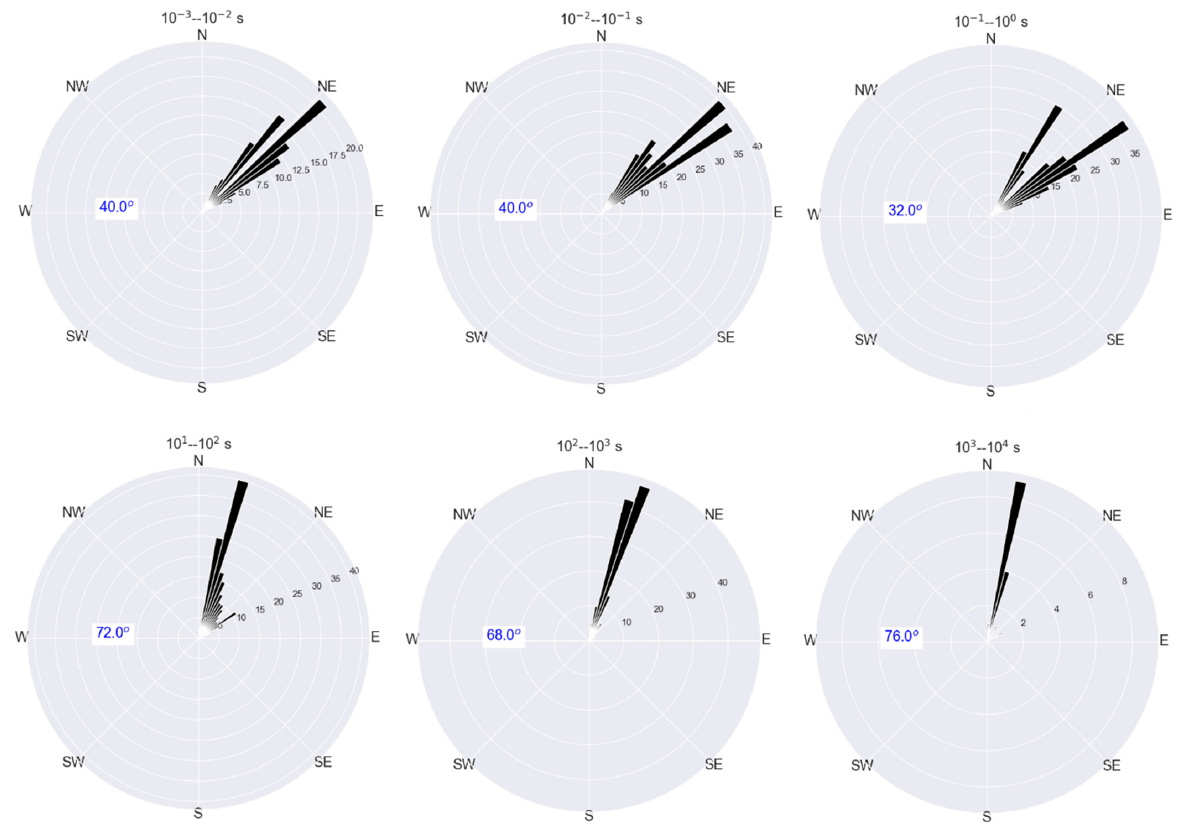
Figure 3. Rose diagram of the orientation of the phase tensor strike for the stations along 2D profile (Figure 1) where each rose diagram corresponds to the mean strike estimated over all 14 MT stations along with the corresponding period range.